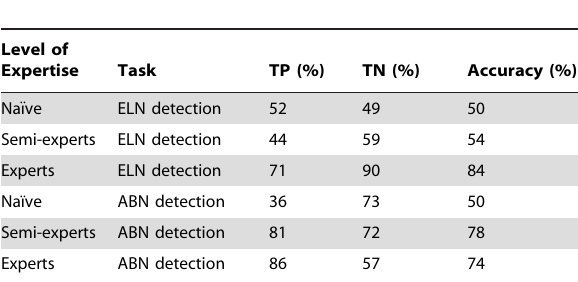
Table 2. Mean performance on ELN and ABN detection across the three expertise